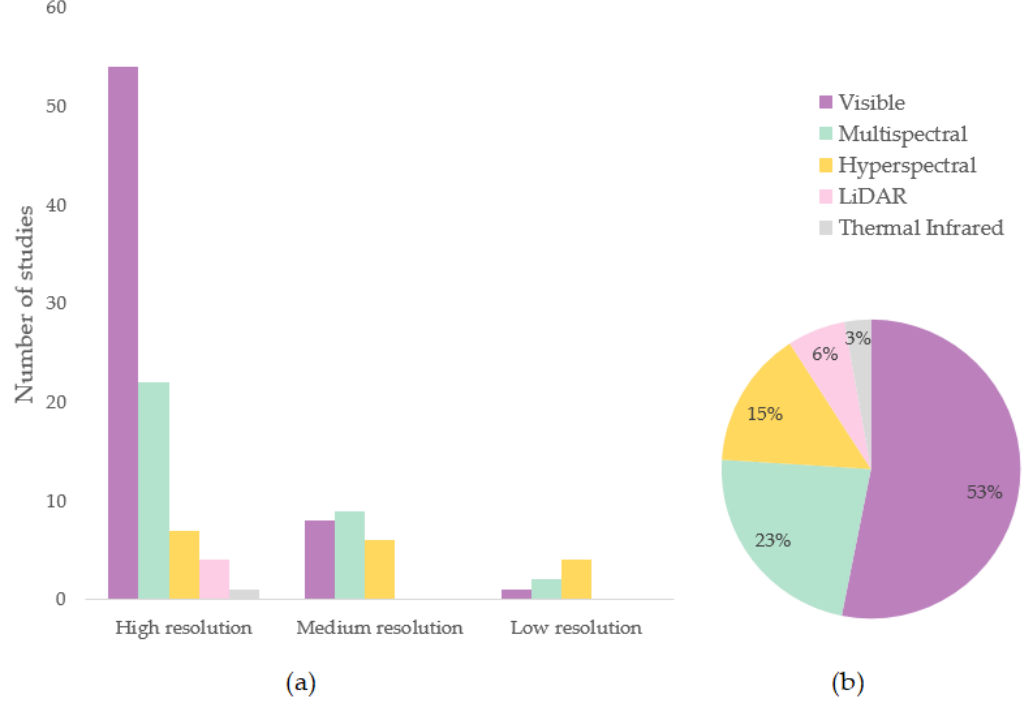
Figure 9. ( a ) Image spatial resolution vs. sensor type, ( b ) Number of studies per sensor technology.